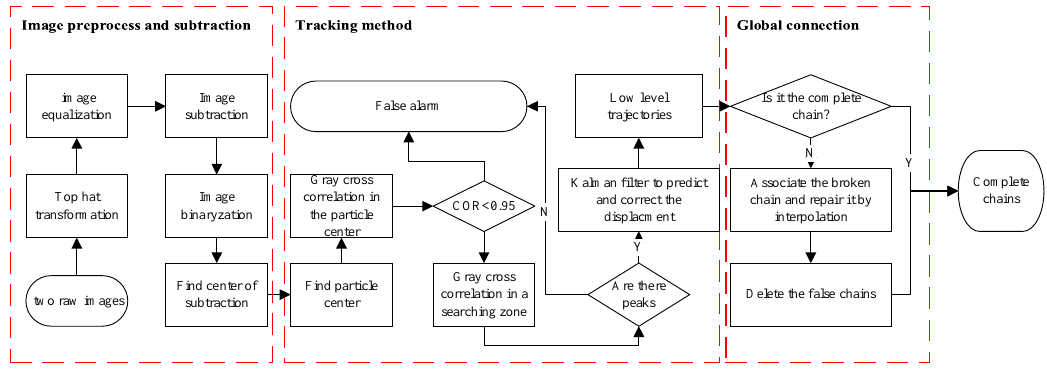
Figure 7. Flowchart of the new method.